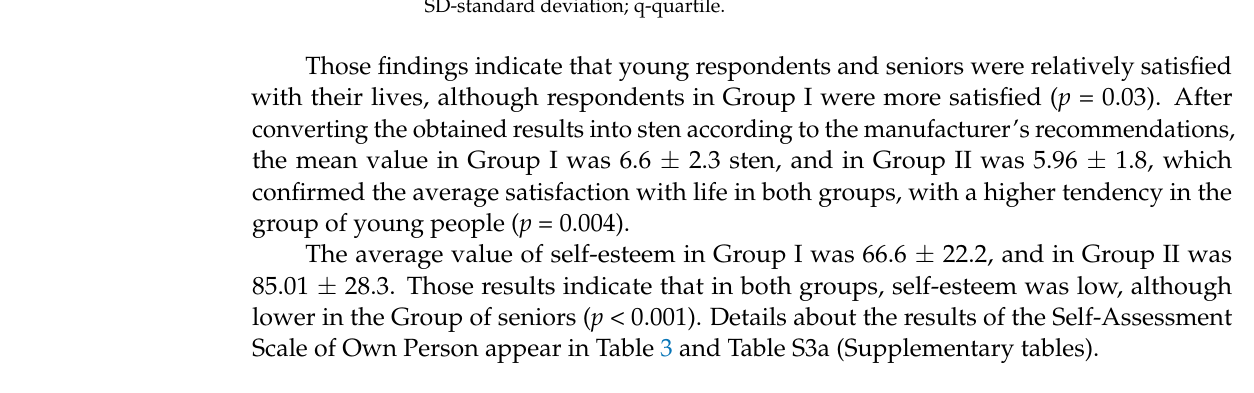
Table 3. Results according to the Self-Assessment Scale of Own